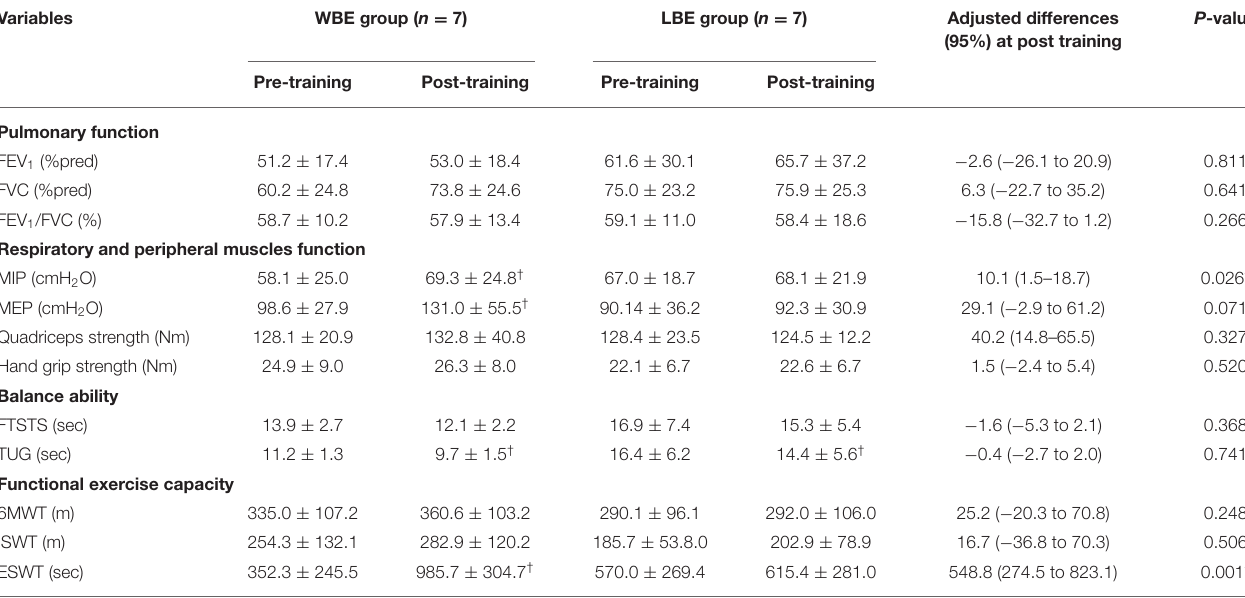
TABLE 4 | Changes in pulmonary function, respiratory and peripheral muscles function, balance ability, and functional exercise capacity outcomes.